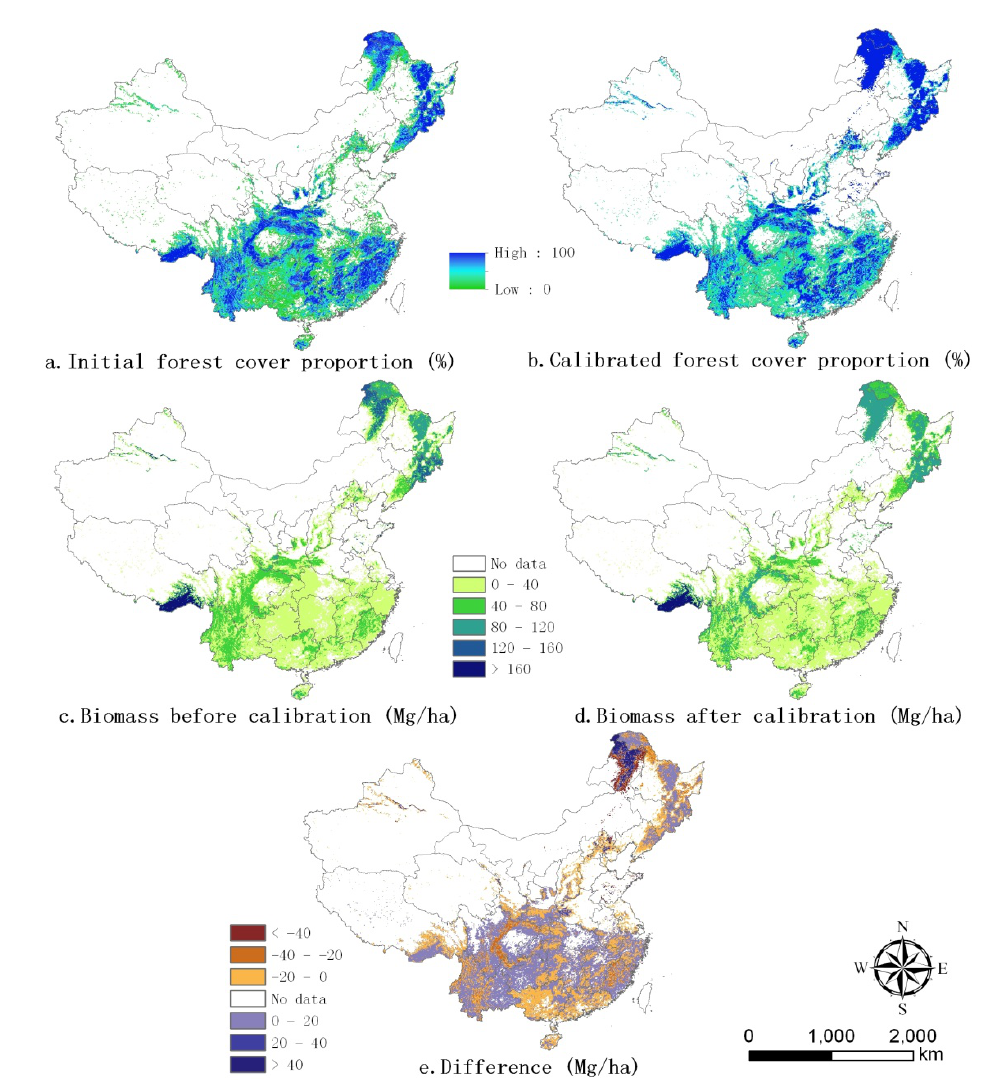
Figure 7. The difference of biomass distribution based on initial and calibrated forest cover proportion maps. ( a ) Initial forest cover proportion (%); ( b ) calibrated forest cover proportion (%); ( c ) biomass before calibration (Mg/ha); ( d ) biomass after calibration (Ma/ha); ( e ) difference